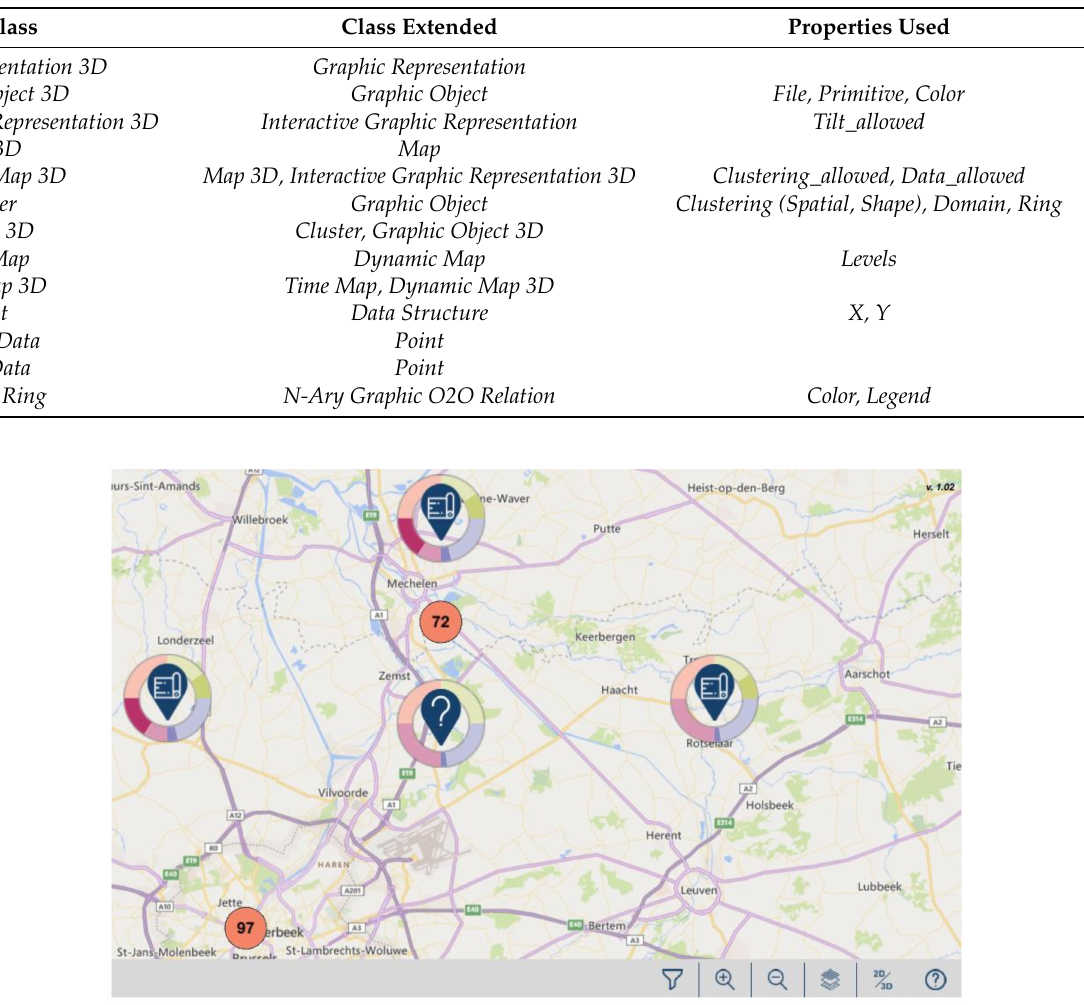
Table 1. Extensions to the VISO ontology implemented by STMaps.